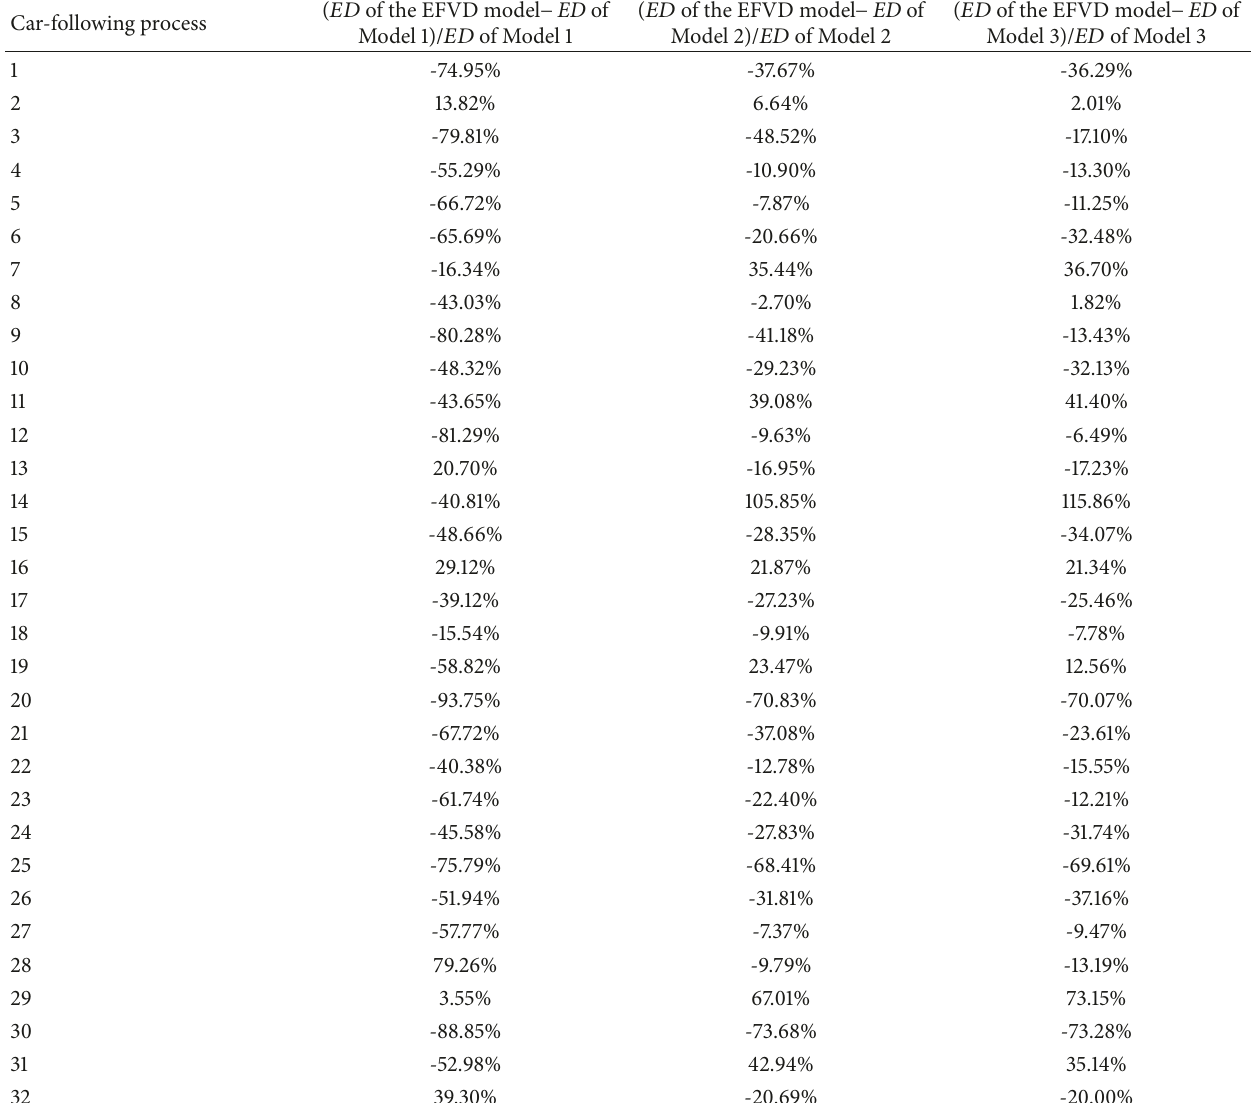
Table 4: Analysis of the EFVD compared with Models 1, 2, and 3 on the basis of the car-following process. Car-following